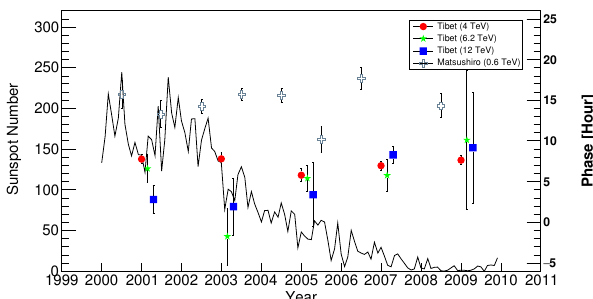
Year1999 2000 2001 2002 2003 2004 2005 2006 2007 2008 2009 2010 2011 Figure 2: The phases of the “additional” anisotropy observed by the Tibet experiment at 4.0 TeV (red circles), 6.2 TeV (green pentagrams) and 12 TeV (blue squares), in comparison with the Matsushiro experiment at 0.6 TeV (gray crosses). The errors are all statistical only. The yearly mean phase observed by Matsushiro in 2007 is omitted in order to exclude large fluctuation due to the insignificant anisotropy. The gray line indicates the monthly mean sunspot